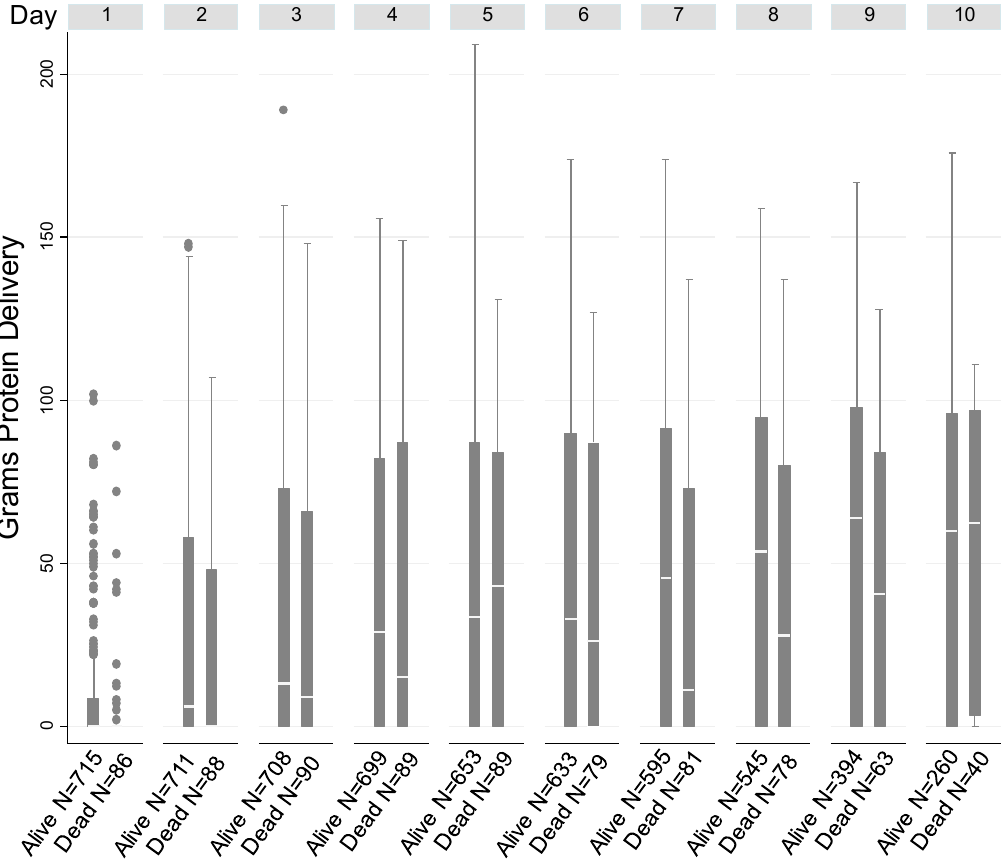
Figure 1. Box plots of daily protein delivery up to 10 days in patients who did and did not survive to 90-day post-discharge mortality, showing the median (white line), the third quartile (Q3) and first quartile (Q1) range of the data and data outliers (observations outside the 9–91 percentile range).